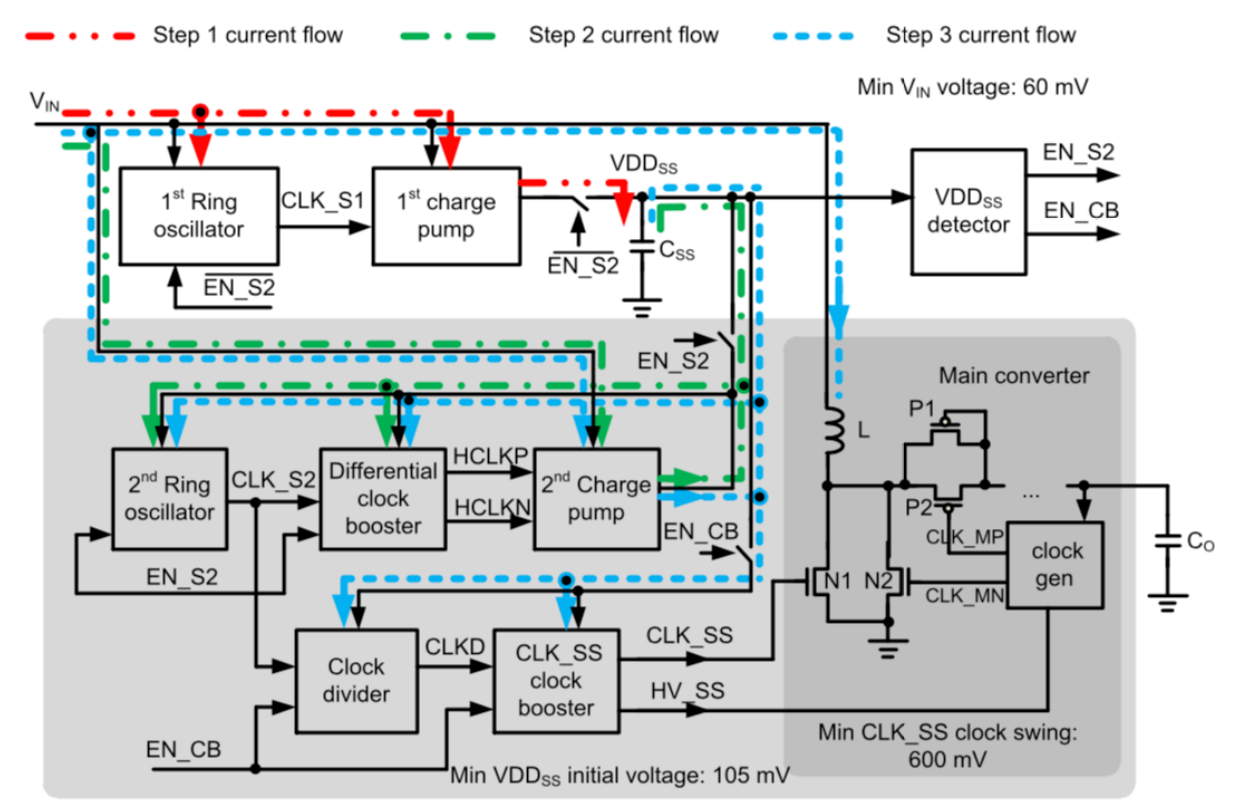
Figure 14. The self start-up block of the converter presented in